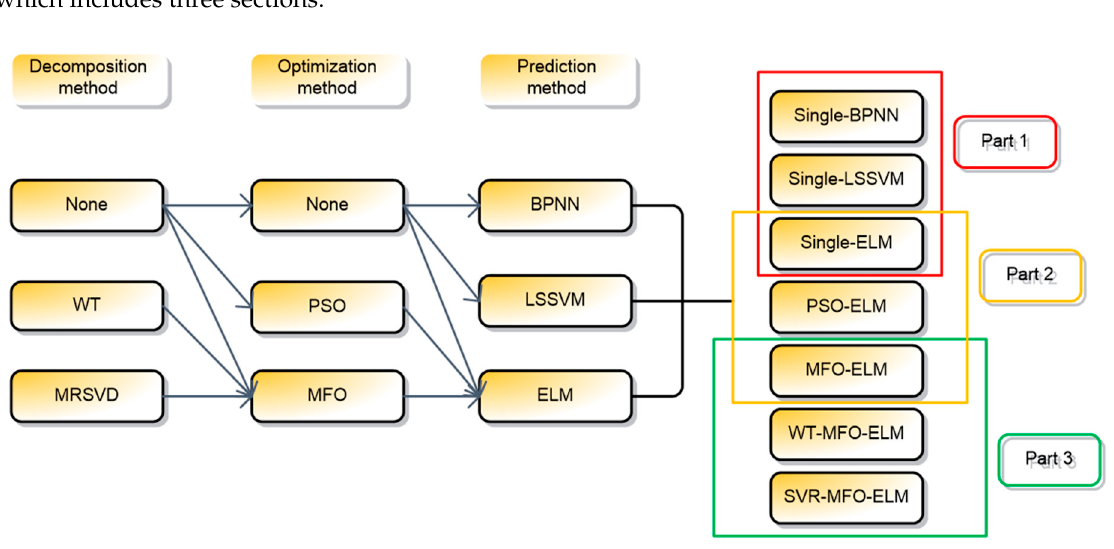
Figure 3. The comparison framework of the carbon price forecasting